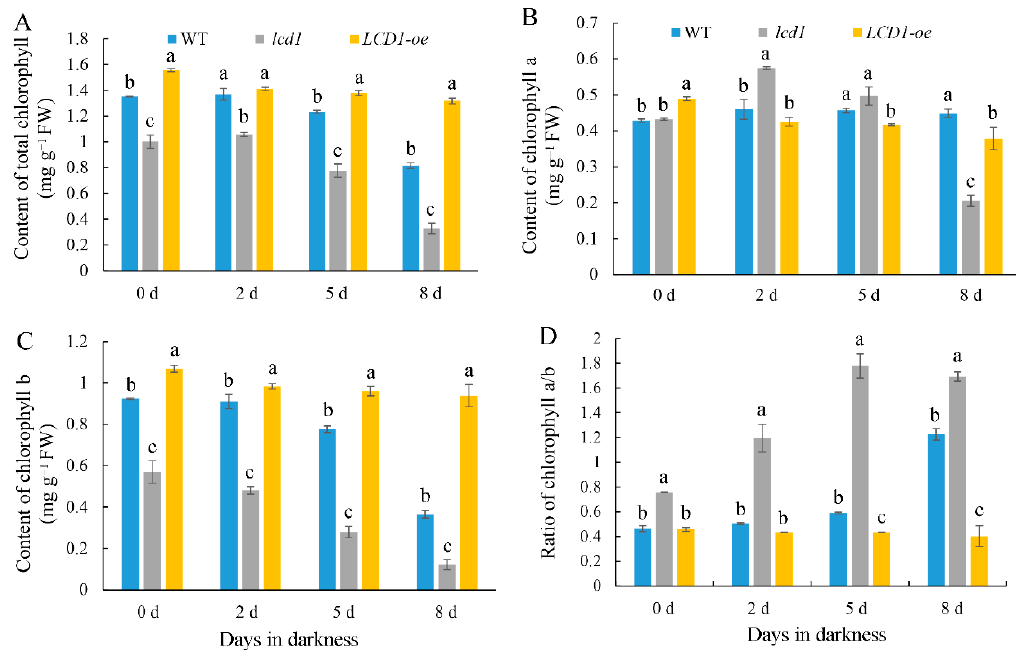
Figure 3. Changes in the contents of ( A ) total chlorophyll, ( B ) chlorophyll a, ( C ) chlorophyll b, and ( D ) the ratio of chlorophyll a/b in dark-stored detached leaves of 6-week-old wild-type (WT), lcd1 , and LCD1-oe tomatoes for 0, 2, 5, and 8 days. Data are means of three biological replicates ± standard deviation (SD). Different letters above the columns stand for significant difference between two values ( p < 0.05) at the same time point.